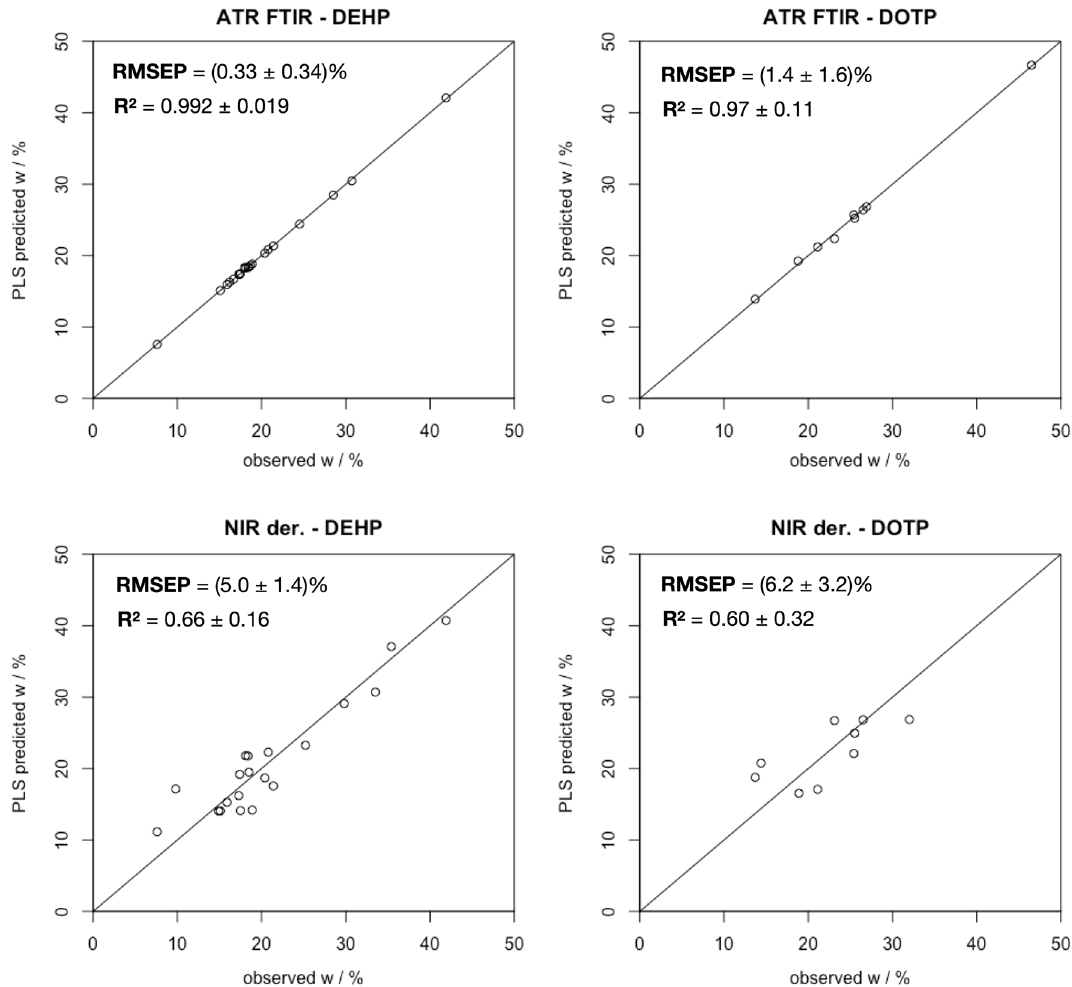
Figure 6. Predicted versus observed w% of DEHP and DOTP for ATR FTIR and numerically differentiated NIR models. Greater linearity indicated by higher R 2 and lower RMSEP values indicates a greater predictive power using ATR FTIR